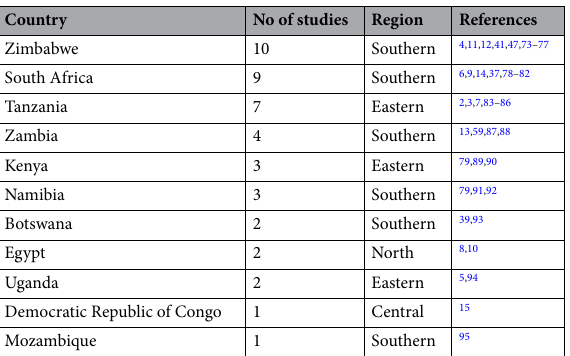
Table 2. Prevalence studies on brucellosis in African wildlife by country in decreasing order with associated region (according to the African Union).